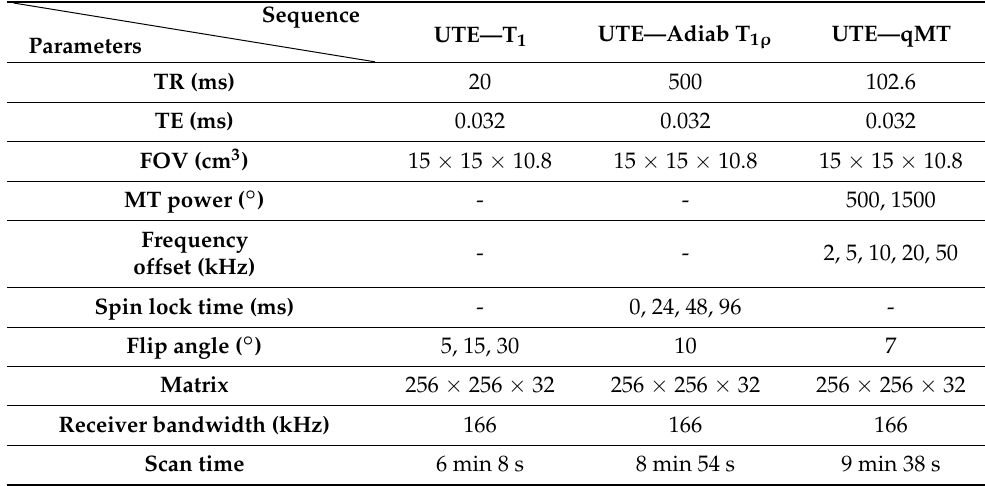
Table 1. This table provides all the parameters used in VFA-UTE-T 1 [7], UTE-Adiab-T 1 ρ [12], and UTE-qMT [15]. Additional B 1 correction was performed using actual flip angle imaging (AFI) technique [28]. For qMT, a Fermi pulse was used for MT